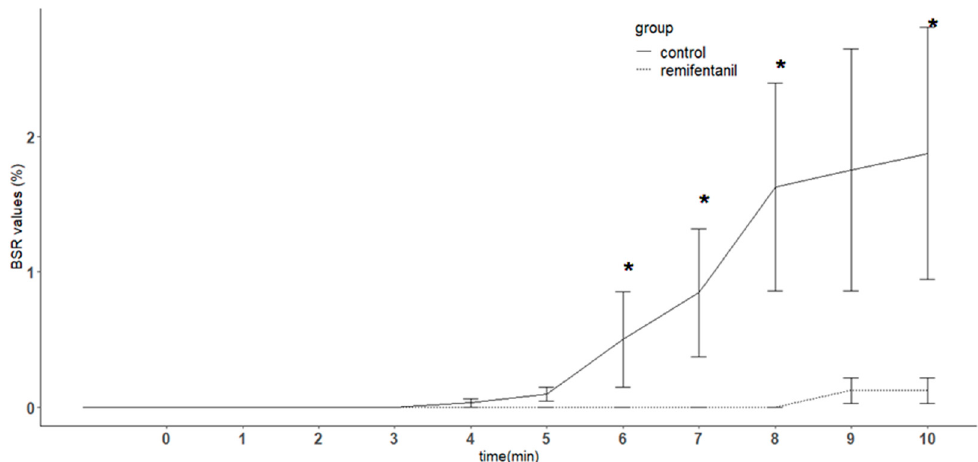
Figure 3. Changes in the burst suppression ratio (BSR) in patients with or without remifentanil infusion. In unconscious patients with propofol at the target e ff ect-site concentration of 5 µ g / mL, a remifentanil target e ff ect-site concentration of 5 ng / mL was infused in the remifentanil group throughout the study period. The control group received normal saline instead of remifentanil. The BSR was less in the remifentanil group compared to the control group ( p < 0.01), and the BSR in the remifentanil group was significantly lower than the control group at 6, 7, 8, 10 min ( p < 0.05). Error bar indicates standard error. In the x axis, time point 0 indicates the time the remifentanil infusion was started at an e ff ect-site concentration of 5 ng / mL. * denotes p < 0.05 compared with control group in corresponding time point.